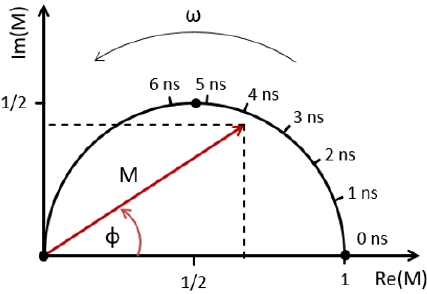
Figure 3. Illustration of the phasor plot (Wohlschläger et al., 2020).